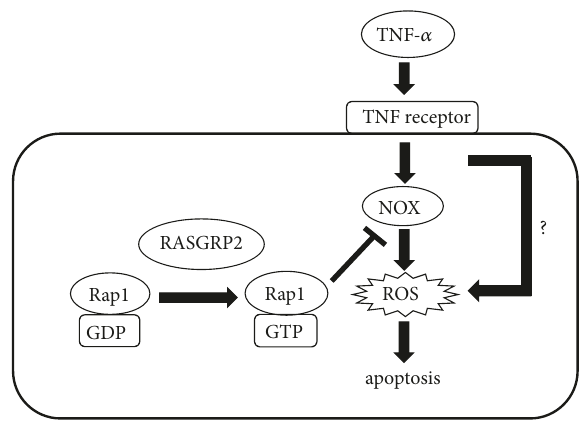
Figure 7: Proposed model of signaling pathway involving RAS- GRP2 in vascular endothelial